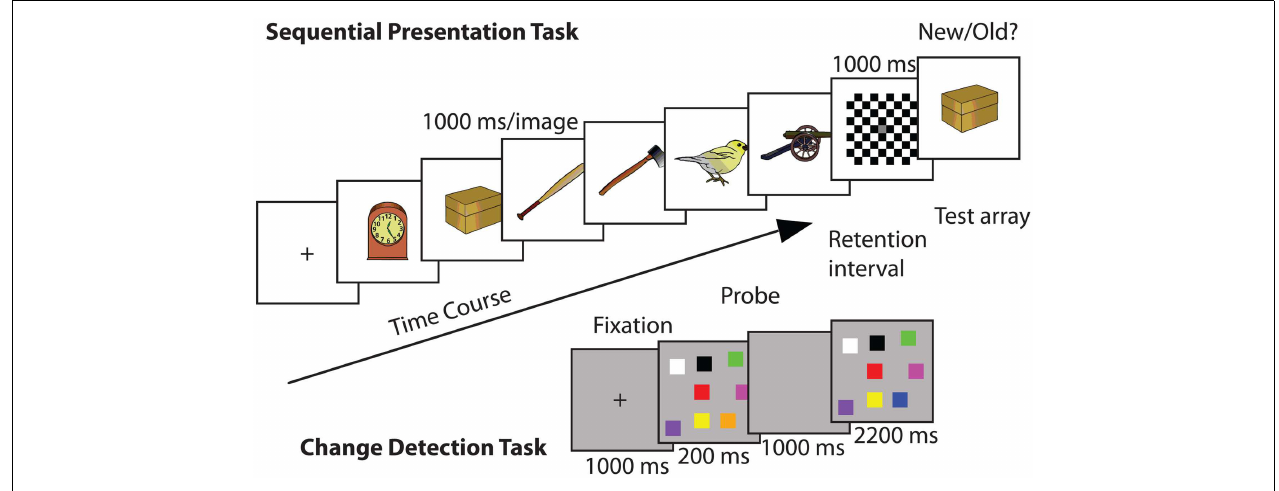
FIGURE 1 | Example trials of each of theWM tasks used in Experiment 1: (top) sequential presentationWM task: in each trial a series of images were presented and after a delay a probe image appeared: (bottom)